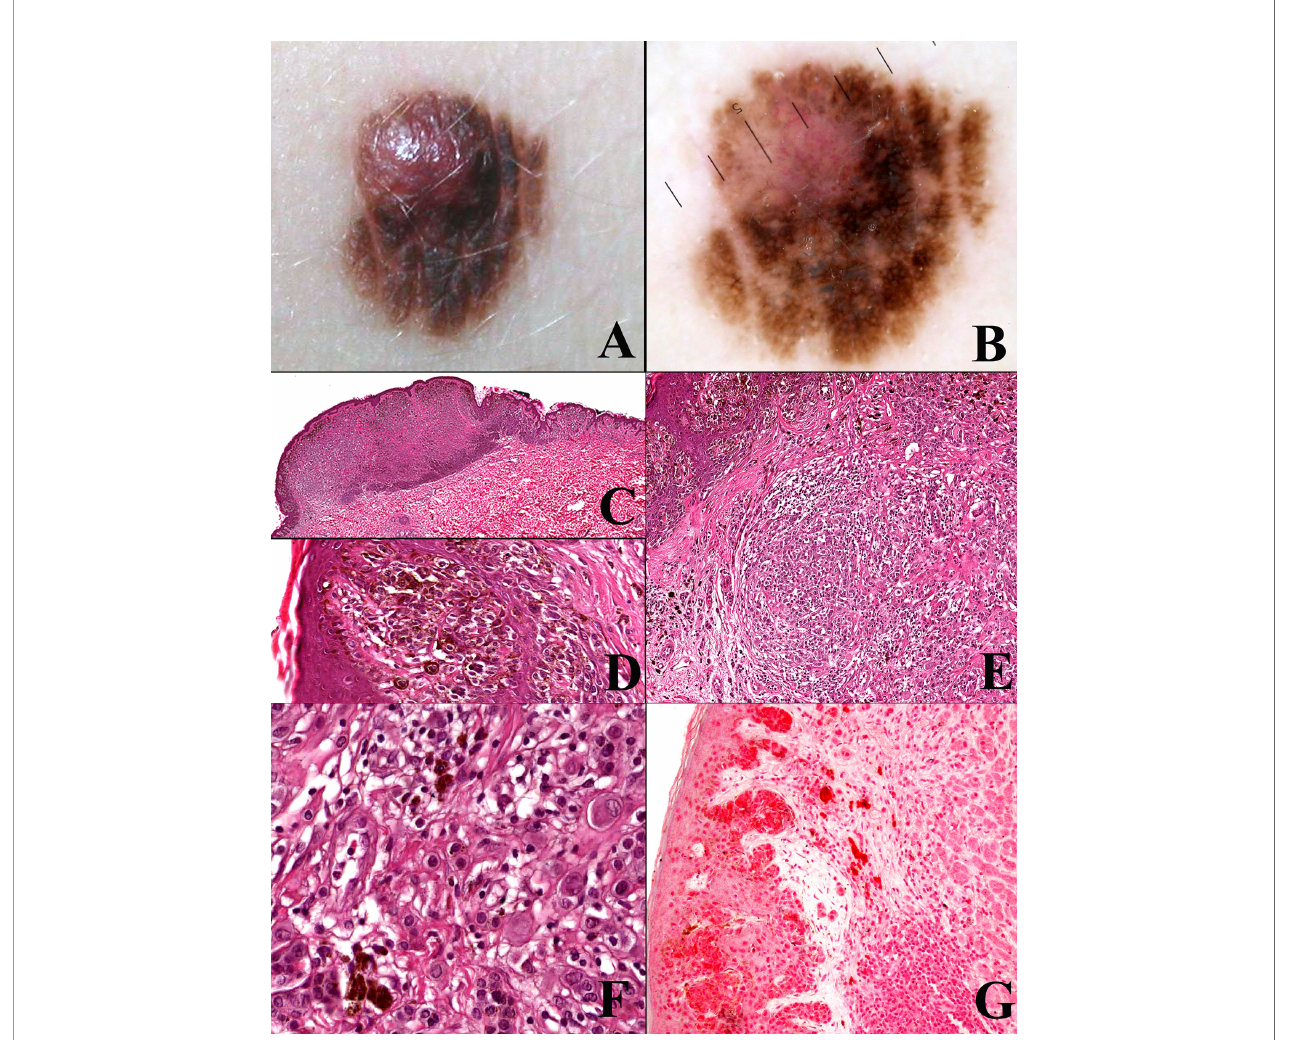
being characterized by a lymphoid cell in fi ltrate ( E ; hematoxylin – eosin, ×250) and nests of nevocytes intermingled with moderately pleomorphic epithelioid melanocytes with “ inclusion-like ” cytoplasms ( F ; hematoxylin – eosin, ×400); all the melanocytic components of this tumor were BRAFv600e mutated protein positive (not shown) and only the dermal epithelioid cell component disclosed loss of the nuclear expression of BAP1 ( G ; ×250). The tumor was interpreted as an early melanoma developing as a neoplastic progression of a common nevus and not as a progression of a